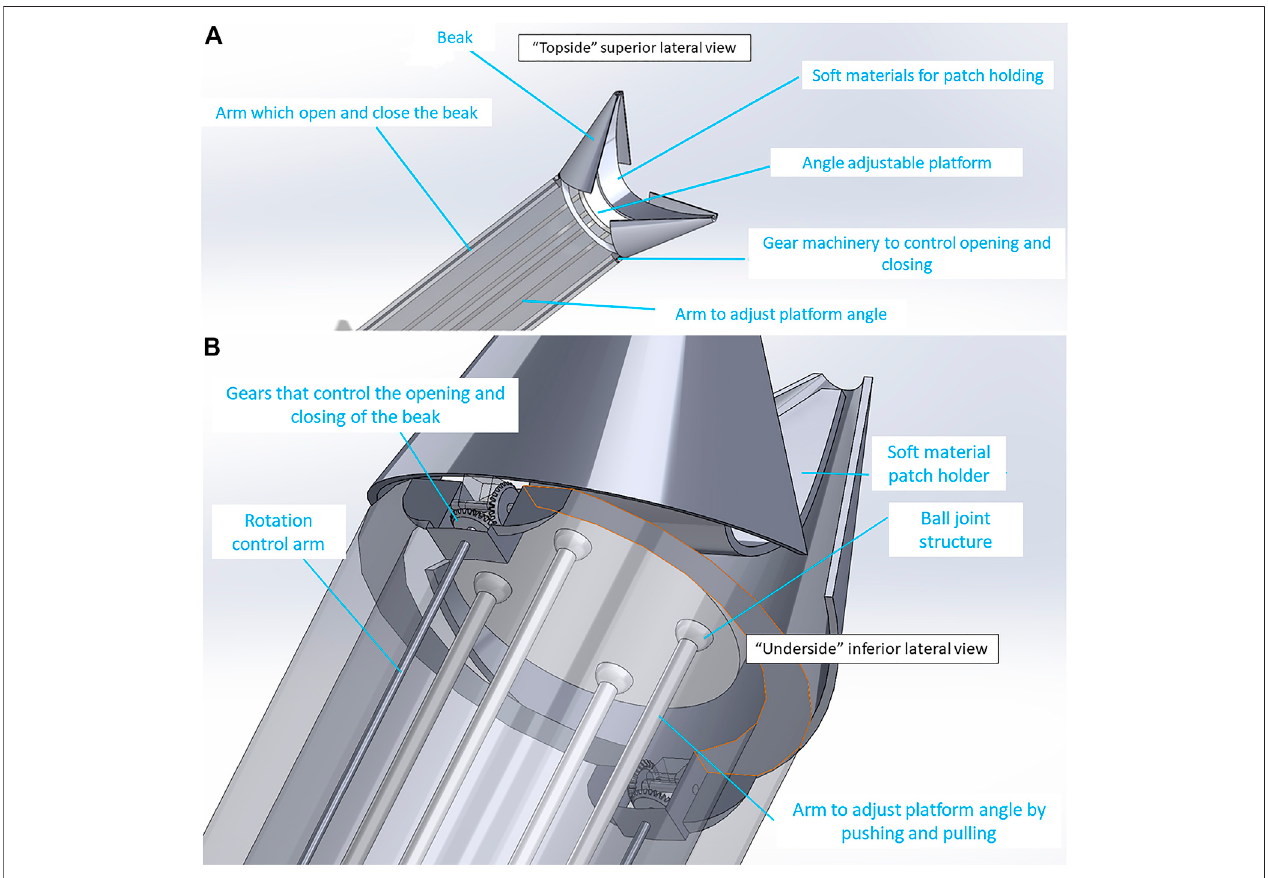
FIGURE 3| “ Shell-Beak ” designwith fl exiblepatchholderconnectedtothepatchdispensersystem. (A) “ Topside ” superiorlateralviewofthedistal(head)oftheinstrument withpartiallyopenbeakand fl exiblepatch-holderwithspaceforaninfoldedpatchbetweenthepatch-holderandtheadjustableplatform. (B) “ Underside ” inferiorlateralviewlooking at the base of the patch platform. Ball joints and gear mechanism are shown which allow for changes to the phasing angle of the platform and opening/closing of the beak, respectively.